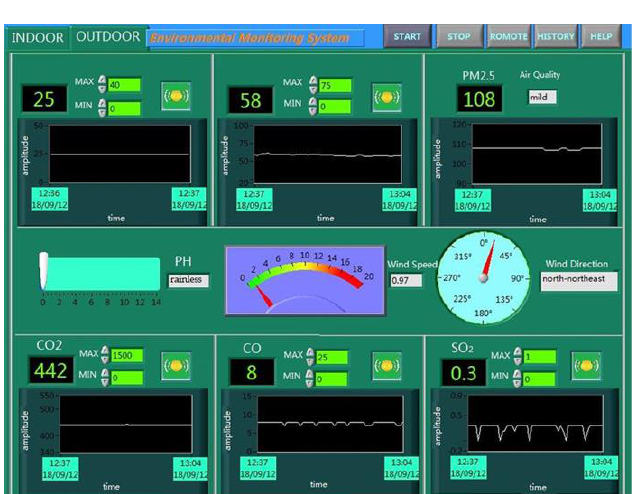
Figure 14. The monitoring of outdoor environment.